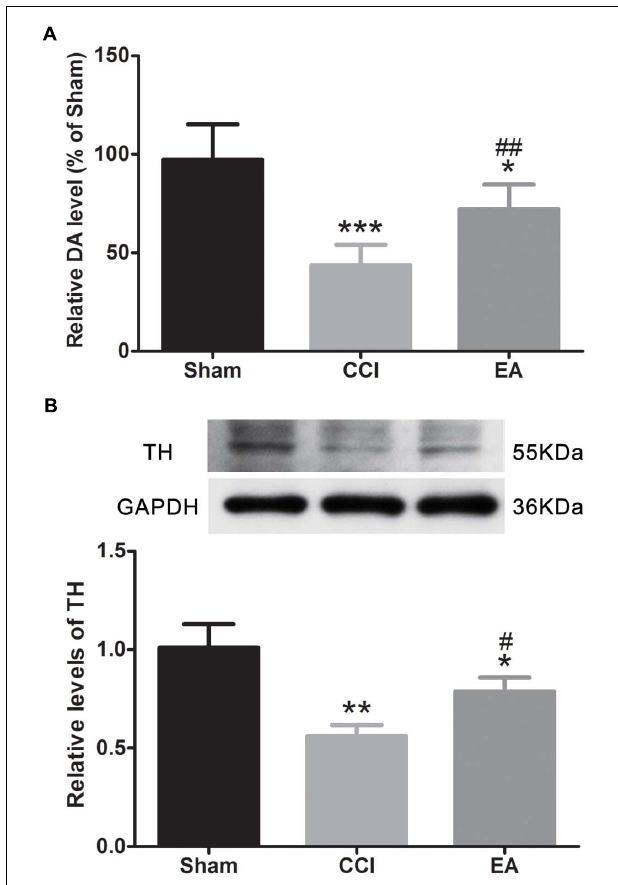
FIGURE 4 | The effects of EA on dopamine (DA) concentration and tyrosine hydroxylase (TH) protein expression in the amygdala. (A) Quantitative analysis of DA concentration ( n = 6 per group); (B) western blot images and quantification showing the protein level of TH ( n = 3 per group). All values are the mean ± SEM. * p < 0.05, ** p < 0.01, *** p < 0.001 vs. the sham group; # p < 0.05, ## p < 0.01 vs. the CCI